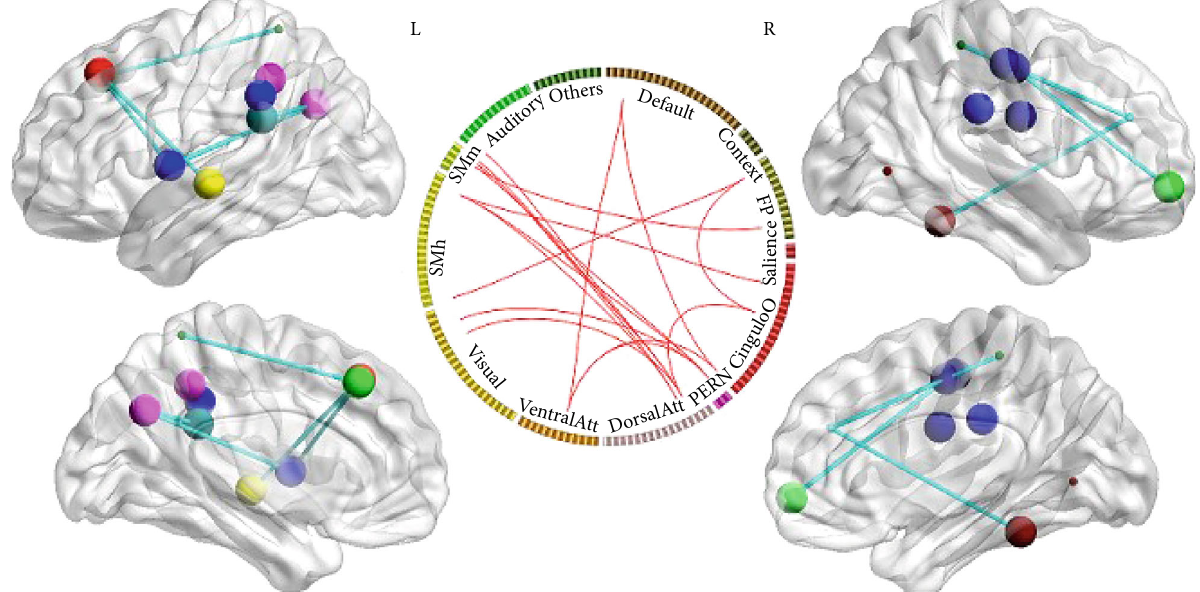
Figure 2: Two-dimension and three-dimension depictions of connectivity analysis result in the EMOTION versus FIX condition. The nodal color denotes a ffi liative community; the nodal size represents the magnitude of nodal betweenness centrality; the edge depicts binarized